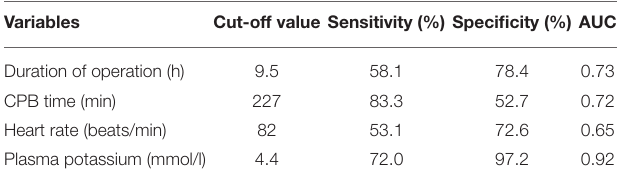
TABLE 3 | ROC curves to obtain diagnostic cut-off values.